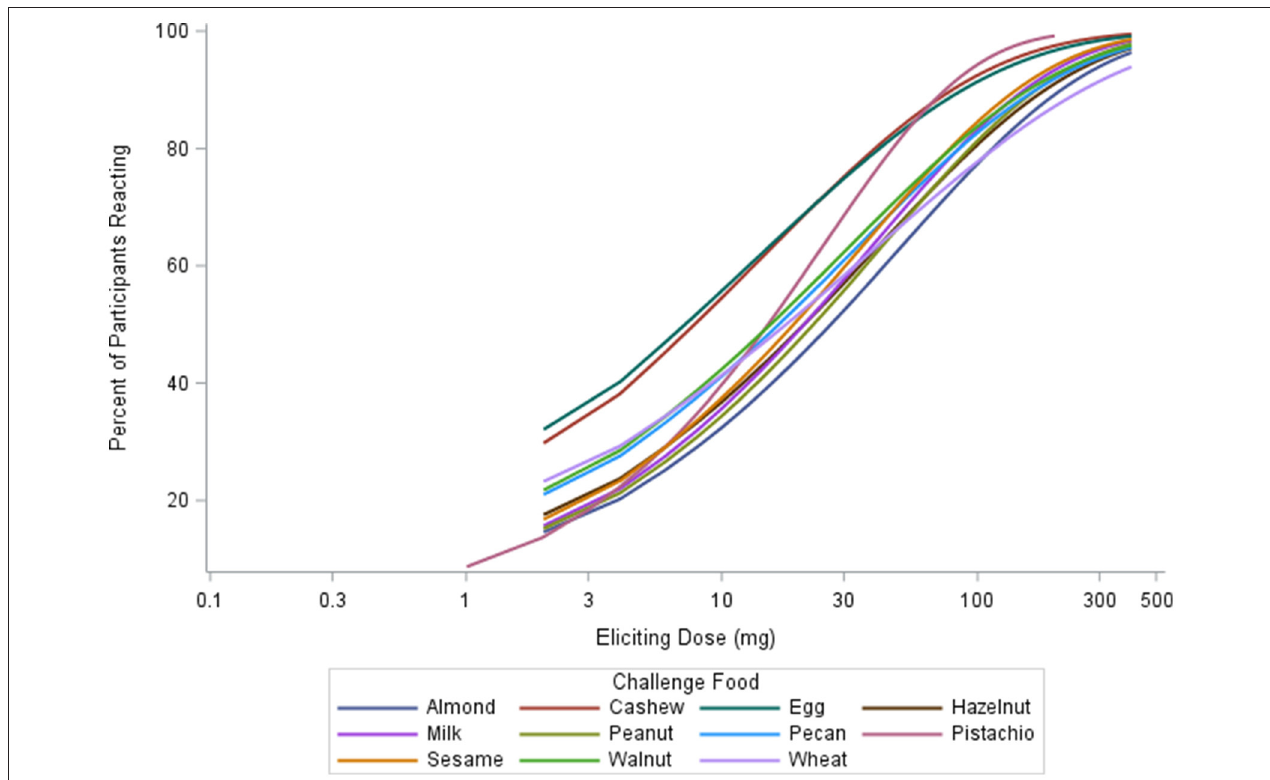
FIGURE 3 | Eliciting dose (ED) thresholds by allergen.